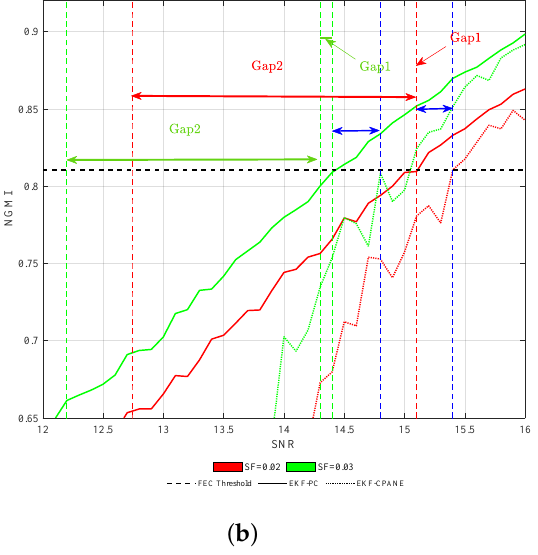
Figure 7. ( a ) Theoretical and practical required SNR to meet the FEC threshold and ( b ) NGMI perfor- mance of EKF-PC for the PS-64QAM with various SF and SNR at the 100 kHz combined